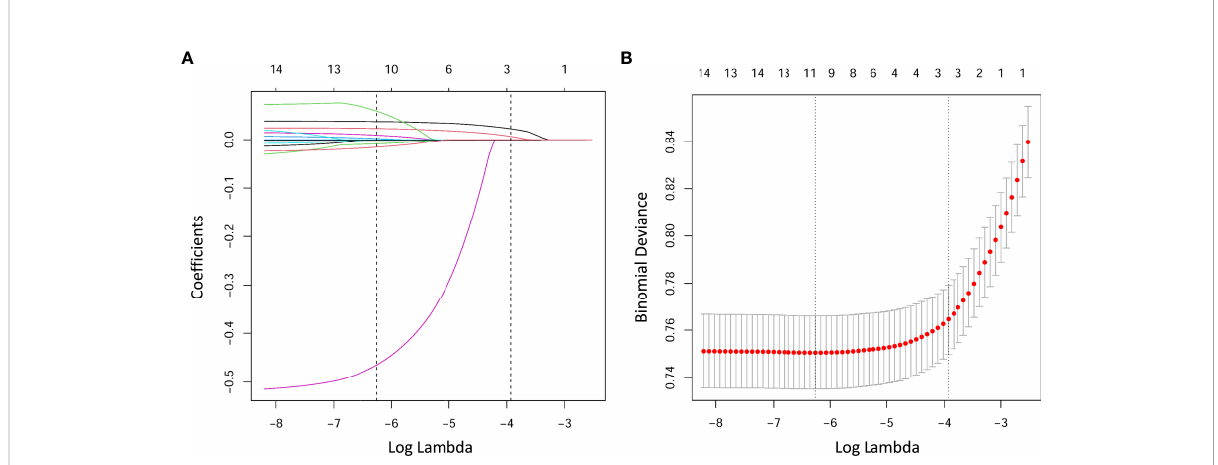
FIGURE 2 Lasso regression analysis of factors related to EPL. (A) LASSO coef fi cient pro fi les of the factors. The vertical line was drawn at the value selected by 10-fold cross-validation, where the optimal l resulted in 13 nonzero coef fi cients. (B) The lambda ( l ) selection process in the LASSO regression is depicted. The value of l that gave the minimum average binomial deviance was applied to select the features. Dotted vertical lines were drawn at the optimal values using the minimum criteria and the 1 − SE criteria. The optimal value of 0.0019 with a log( l ) value of -6.2754 was